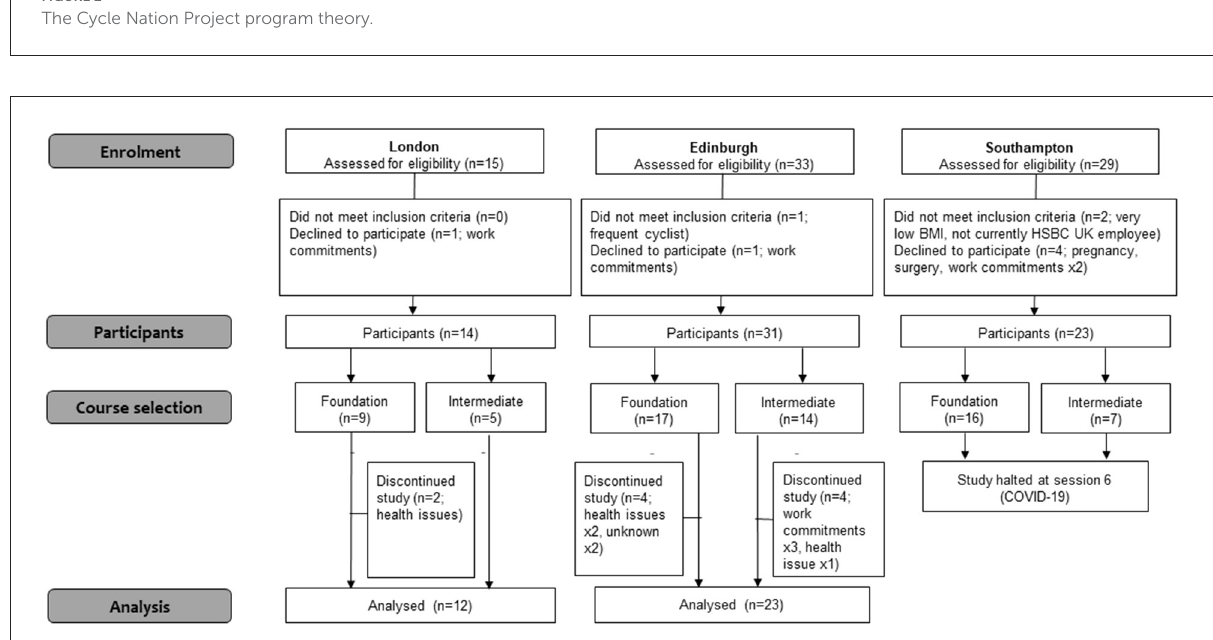
FIGURE3 Flow of participants through the Cycle Nation Project feasibilty